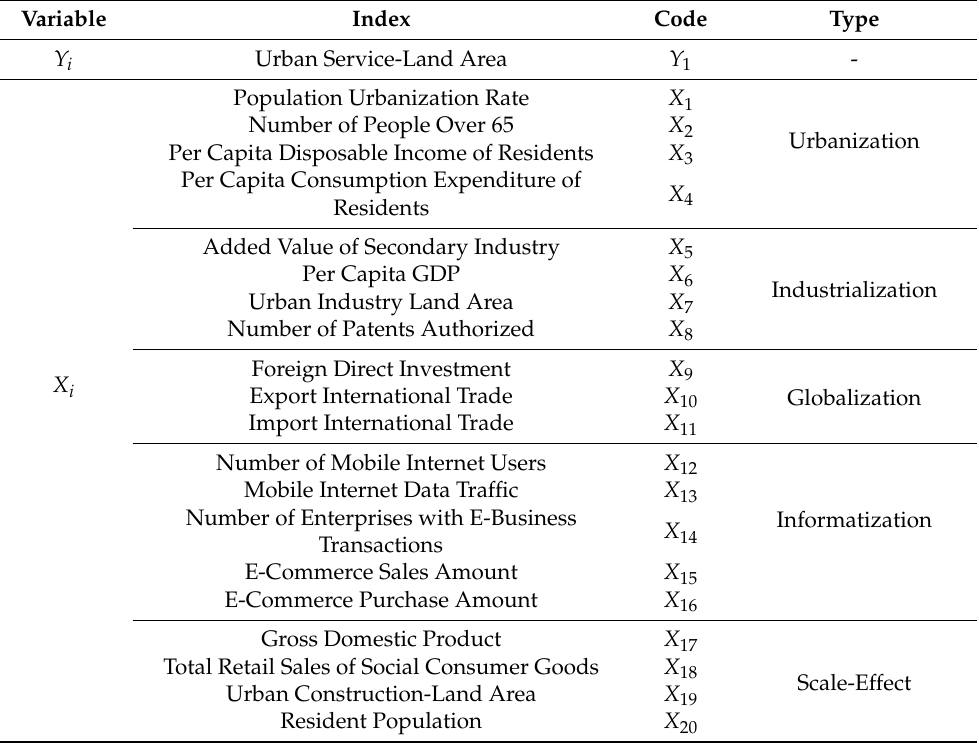
Table 2. Model variable